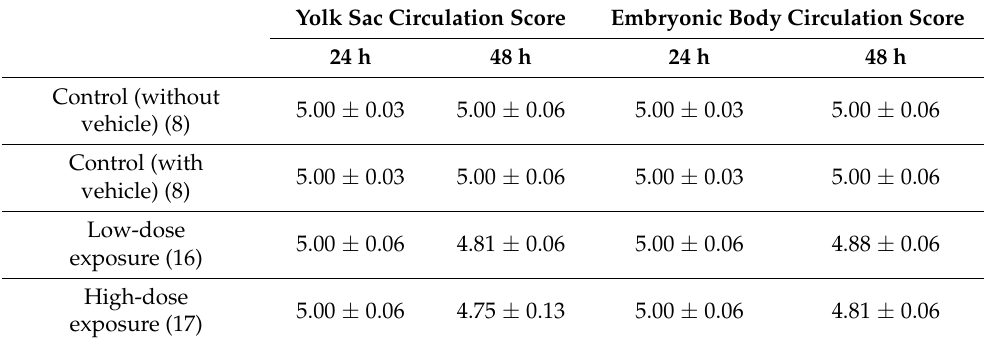
Table 3. Yolk sac and embryonic body circulation scores of rat embryos cultured for 24 and 48